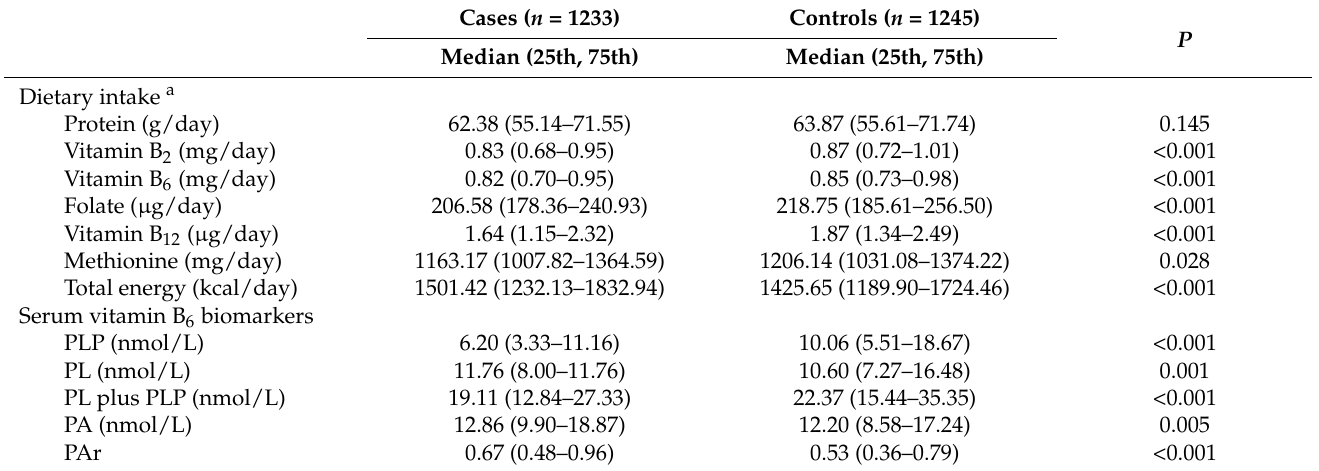
Table 2. Selected dietary factors and serum concentrations of vitamin B 6 biomarkers between colorectal cancer cases and controls.